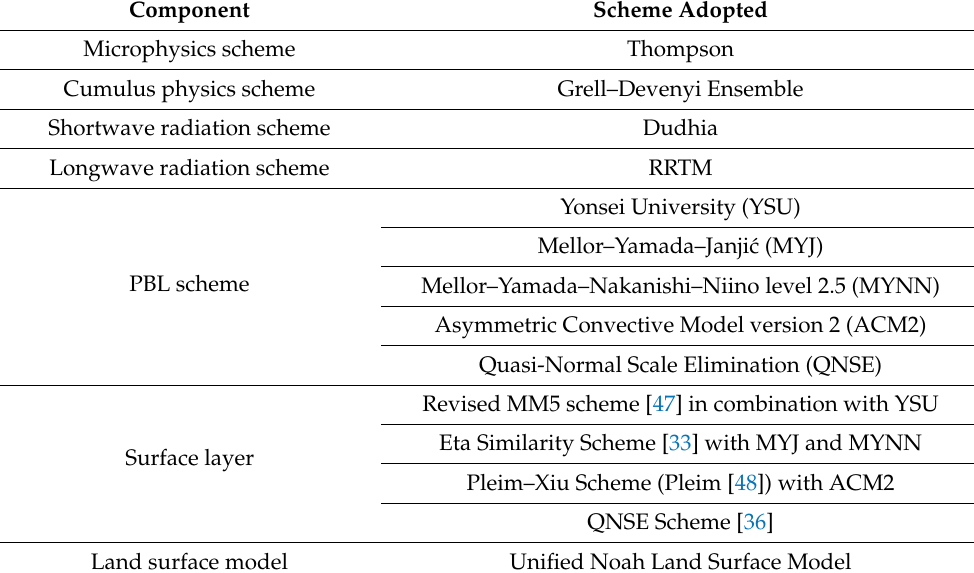
Table 1. Main WRF physical options selected for the